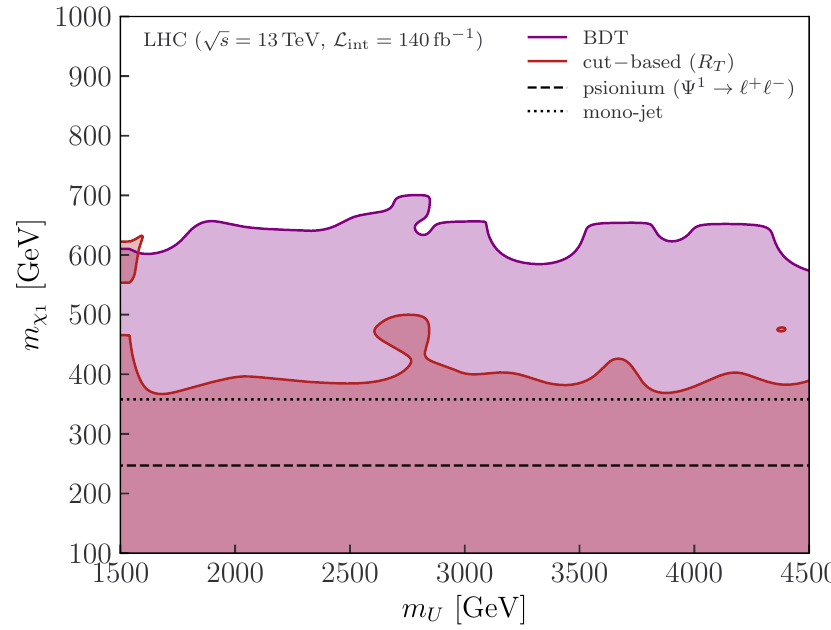
Figure 7 . Exclusion limits at 95% CL for the cut-based analysis based on the R T observable (red region) and the multivariate analysis based on a combination of low-level and high-level observables (purple region). For comparison, the psionium and monojet limits are also